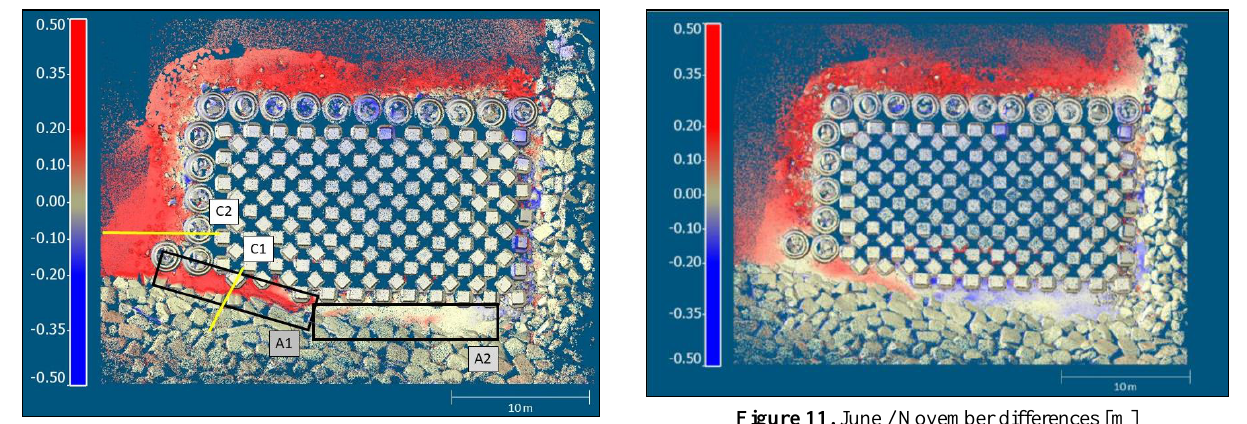
We can take a closer look at the displacements of the blocks with the 3D model time series as shown on Figure 12 where the block on the left represents the South-East corner of the structure. Here, and for the following examples, dates are colour coded as follows: green for April, yellow for May, blue for June and red for November. We first notice that the left block did not move between April and November whereas the other two show visible displacements between May and June.